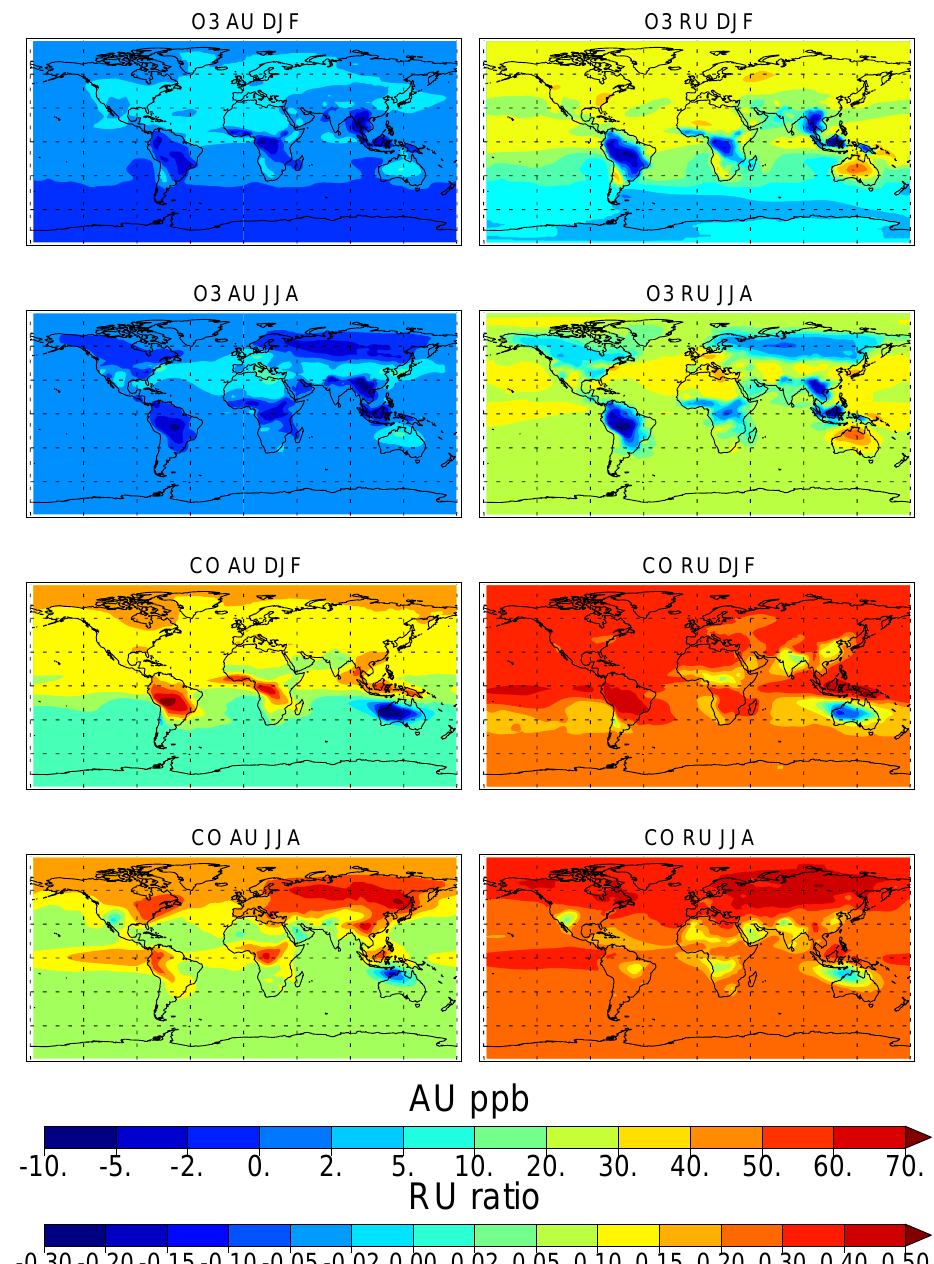
Fig. 11. The Absolute Uncertainty (AU) and Relative Uncertainty (RU) introduced by the variability in biogenic emission estimates for tropospheric O 3 (top) and CO (bottom). Values are shown for seasons DJF and